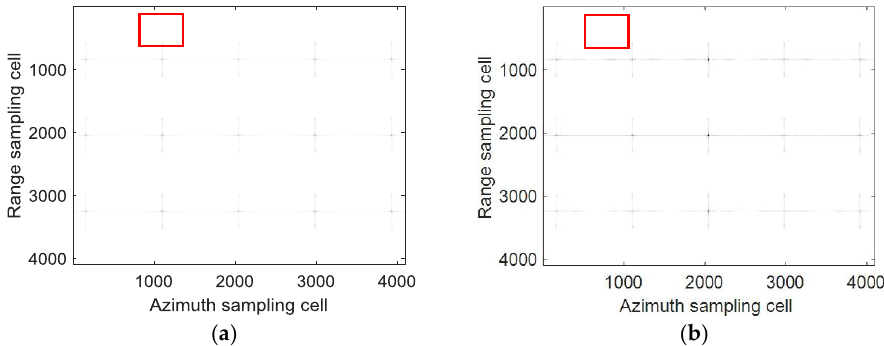
Figure 6. Imaging results of point targets: ( a ) standard full-aperture chirp scaling algorithm (CSA); ( b ) sub-aperture chirp scaling (CS)-dechirp algorithm.